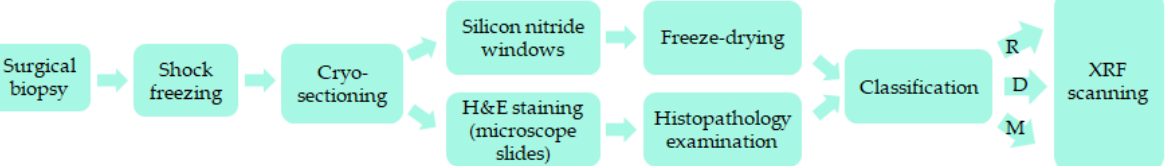
Table 3. Obtained classification matrix for matching fibres by multivariate discriminate analysis for 30% of randomly selected fibres, which were not involved in creating the model. Abbreviations: D— dystrophies group; M—myopathy group; R—reference group.